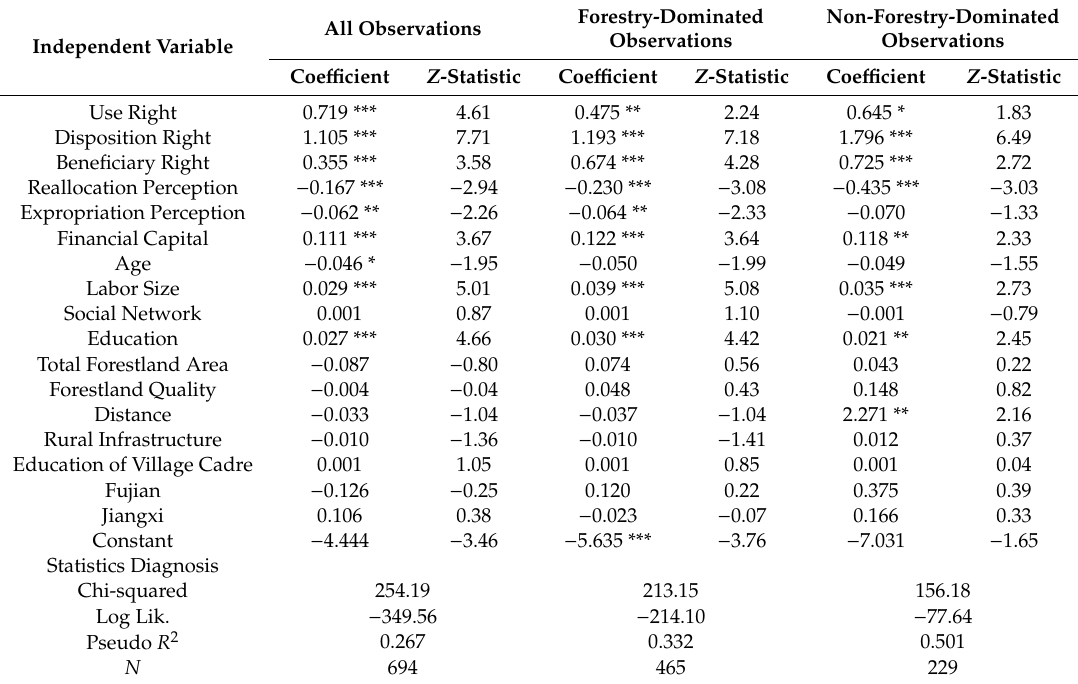
Table 3. Estimation results: Binary probit models for the probability of household labor transfer.